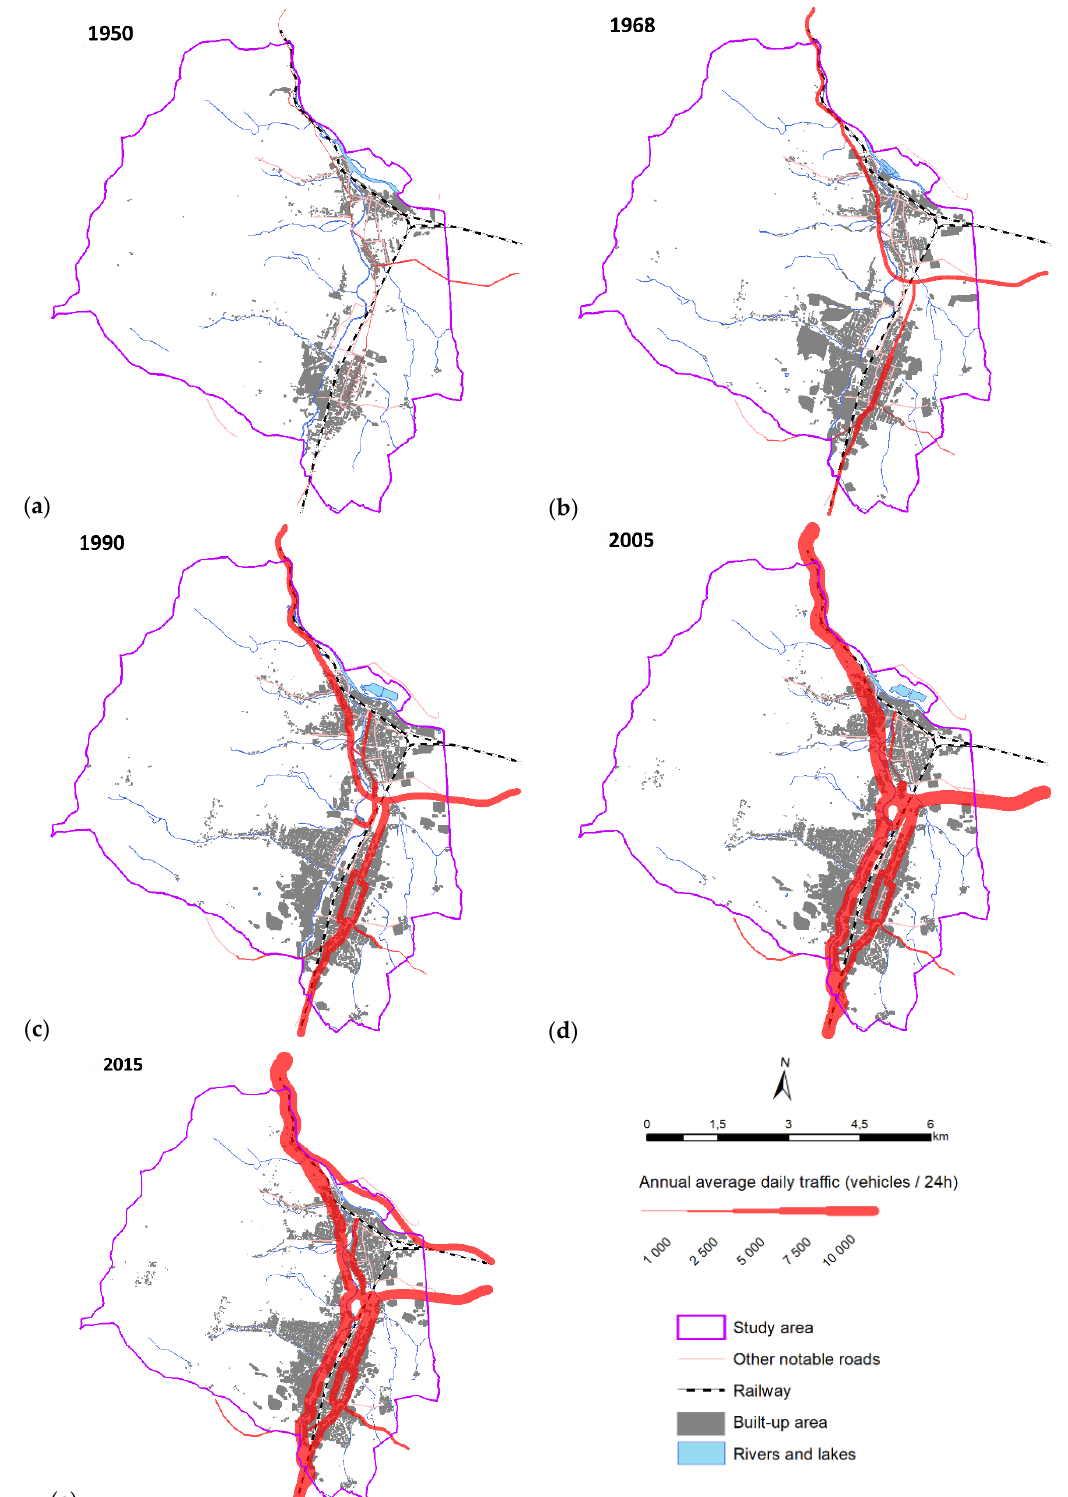
Figure 5. The development in the main road transport networks and traffic volume trends ( a – e ). Moreover, relevant road transport growth predictions propose a further rise in the intensities; I/65 and I/18 can then be theoretically expected to carry, before the year 2040, up to 33.2 and 39.4